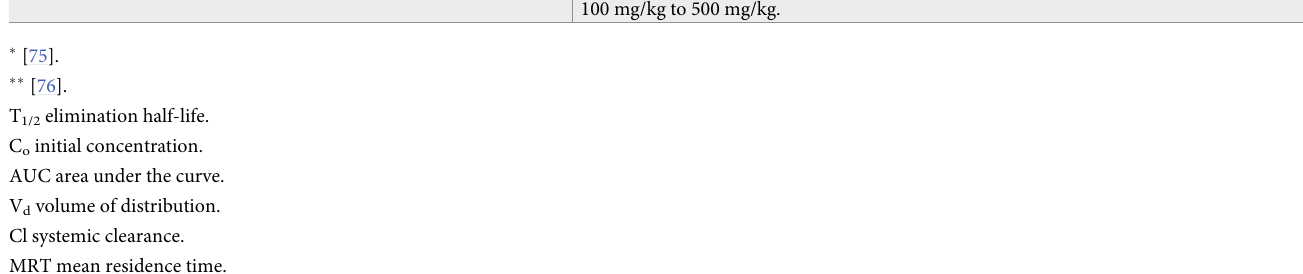
effect of both flavonoids against trypsin and the calculated IC values were 104 µ M (HST) and 50 127 µ M (HSD) [78], respectively. The IC values for HST and HSD described in our study are 50 10 to 50 times lower and this concentration will probably not affect trypsin activity. The same applies to the human pancreatic elastase and HST [79]. HST was reported to affect CHIKV intracellular replication using a CHIKV replicon cell- line. In the same study the authors demonstrated that HST possess no antiviral activity against anti-entry, anti-adsorption, direct virucidal assays and the stages of CHIKV replication cycle [29]. Similar results were observed for HSD against CHIKV and HST against ZIKV in plaque reduction assay. Vero cells infected with 50 PFU of CHIKV or ZIKV, after 48 h incubation,